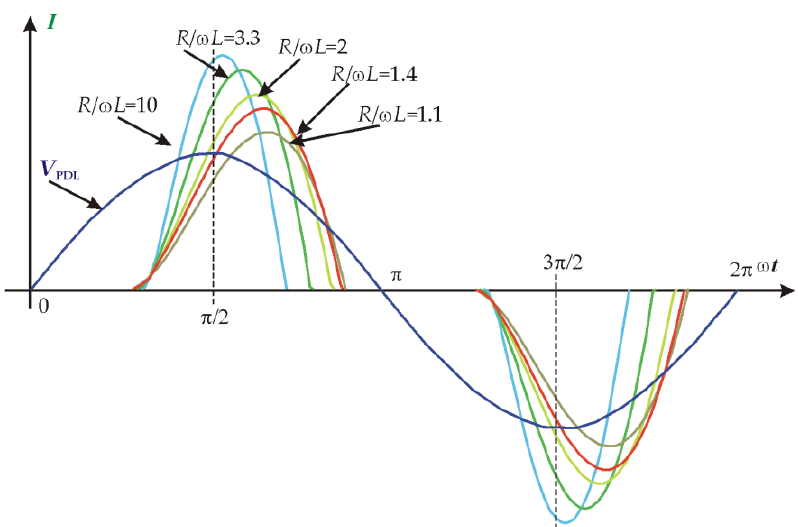
Figure 6. VFD input current pulse i ( t ) position at different PDL internal R / ωL ratios calculated on the basis of Equations (16) – (18).